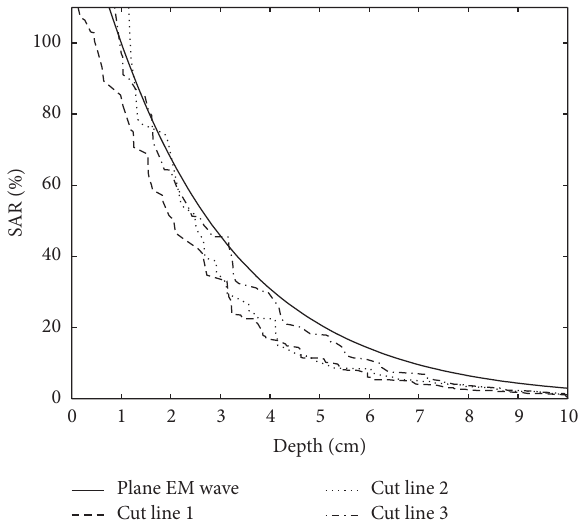
Figure 8: SAR distribution corresponding to plane EM wave propa- gating throughthetreatedarea considered here(muscletissue).SAR distribution along three line segments (cut lines) which lie in the plane perpendicular to the water bolus/treated area interface. The plane cuts the inductive posts in the middle. Cut lines 1, 2, and 3 start at the interface, lead into the treated area, and are located between the first and the second inductive posts, between the fourth and the fifth inductive posts, and in front of the third inductive post, respectively. The SAR values are given as percentages of the SAR value of the plane EM wave at the depth of 1cm.